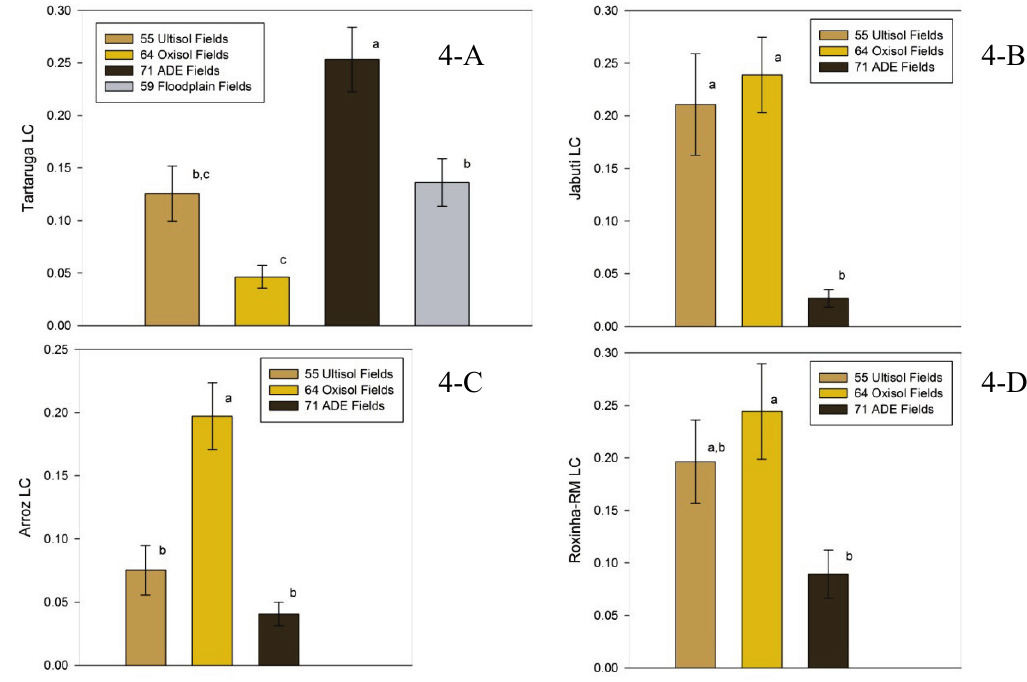
Figure 4. ANOVA comparing mean lc for key landraces in different types of soil along the middle Madeira River. Letters indicate significantly different means based on Tukey’s post-hoc test (p < 0.05). Vertical lines on each bar represent the standard